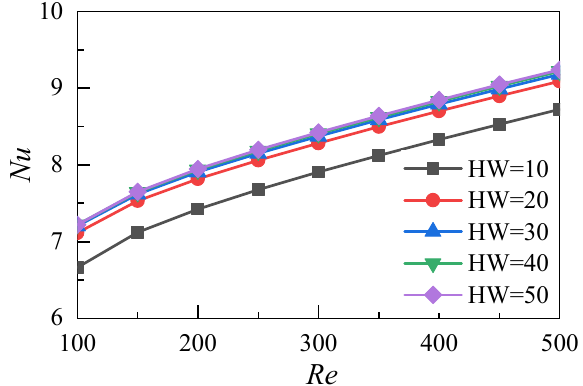
Figure 14. Nusselt number distributions of microchannels with different aspect ratios.